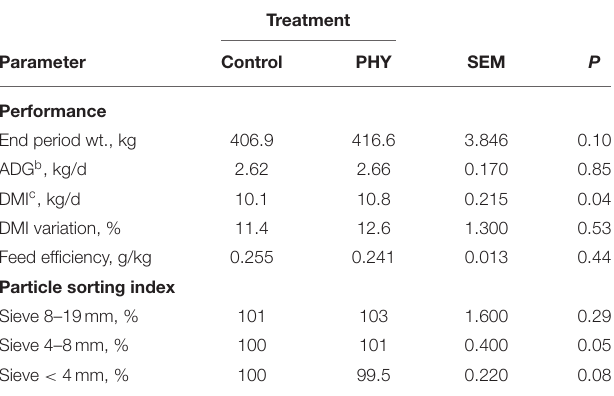
TABLE 2 | Comparison of dry matter intake, average daily gain, and particle sorting index of crossbred finishing bulls during the adaptation period: from day 8 to day 25 a